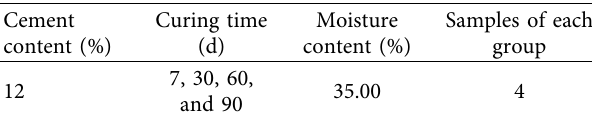
Table 4: The parameters of dynamic impact test. Cement